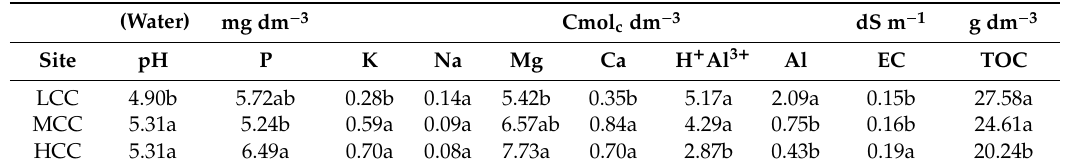
Table 2. Soil chemical attributes in three areas with a clay gradient (LCC: Low Clay Content, MCC: Medium Clay Content, HCC: High Clay Content). TOC: total organic carbon, EC: electrical conductivity, H + Al 3 + : potential acidity.